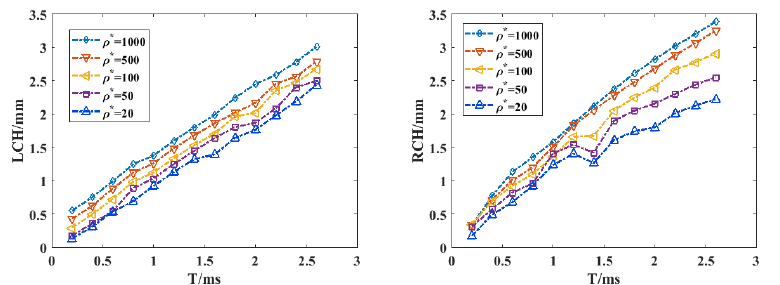
Figure 13. Crowns heights at different density ratio when θ = 30 ◦ .